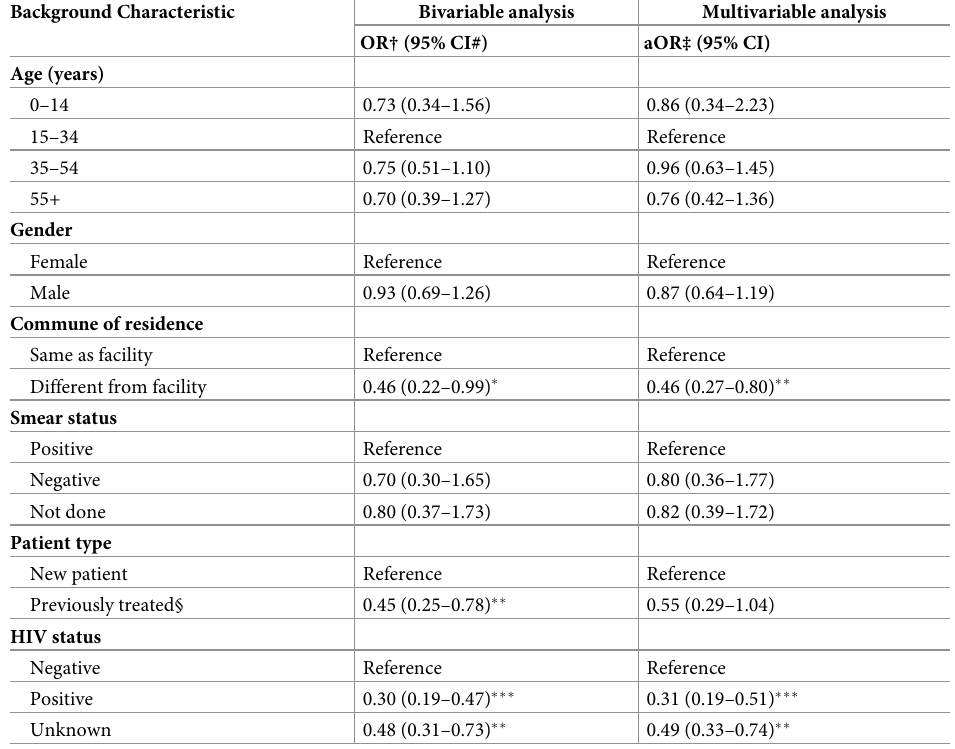
Table 3. Factors associated with treatment success in patients receiving care in health facilities affected by Hurri- cane